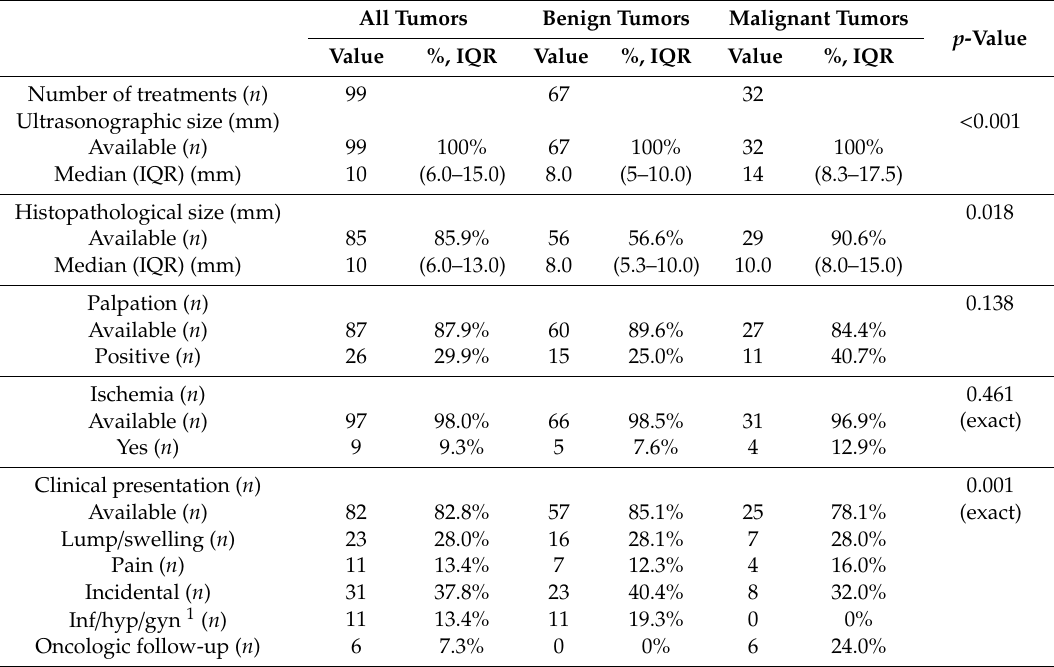
Table 2. Summary of data analyzed at the treatment